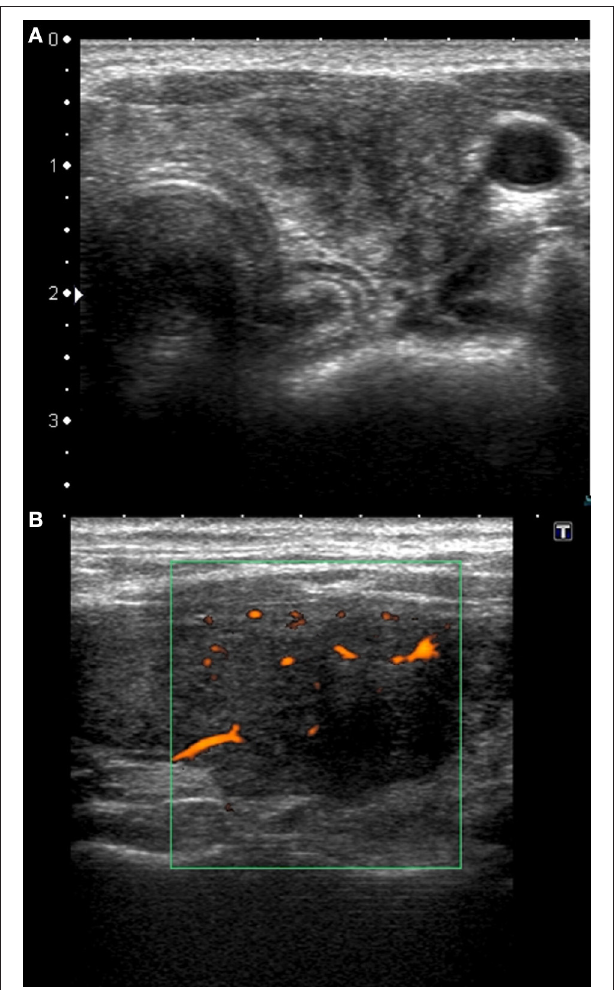
FIGURE 1 | Typical sonographic patterns of SAT in patients with HLA-B*35, C*04:01, and DRB1*01, without HLA-B*18:01. (A) Hypoechoic, strongly heterogeneous, areas with poorly defined margins; (B) hypoechoic blurred areas with decreased or absent vascularization. lobe ( p = 0.003, as compared to other groups) ( Figure 2 ).